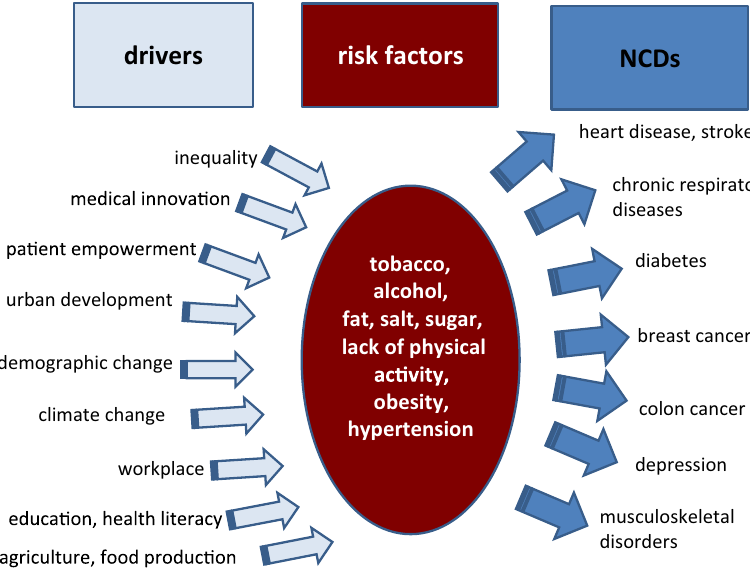
Fig. 1 Example for